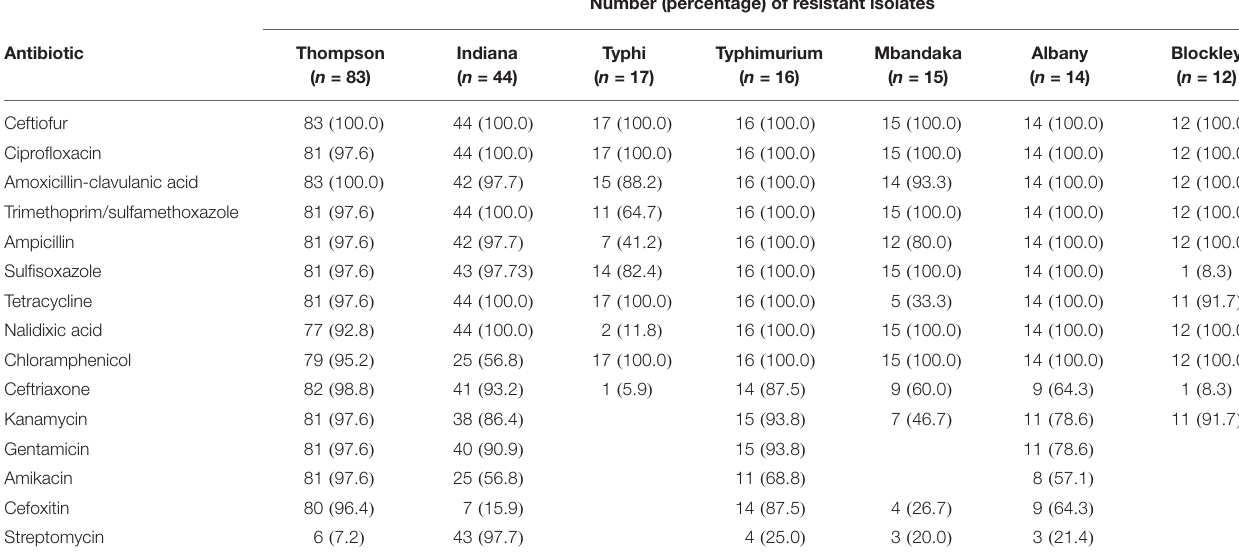
Number (percentage) of resistant isolates